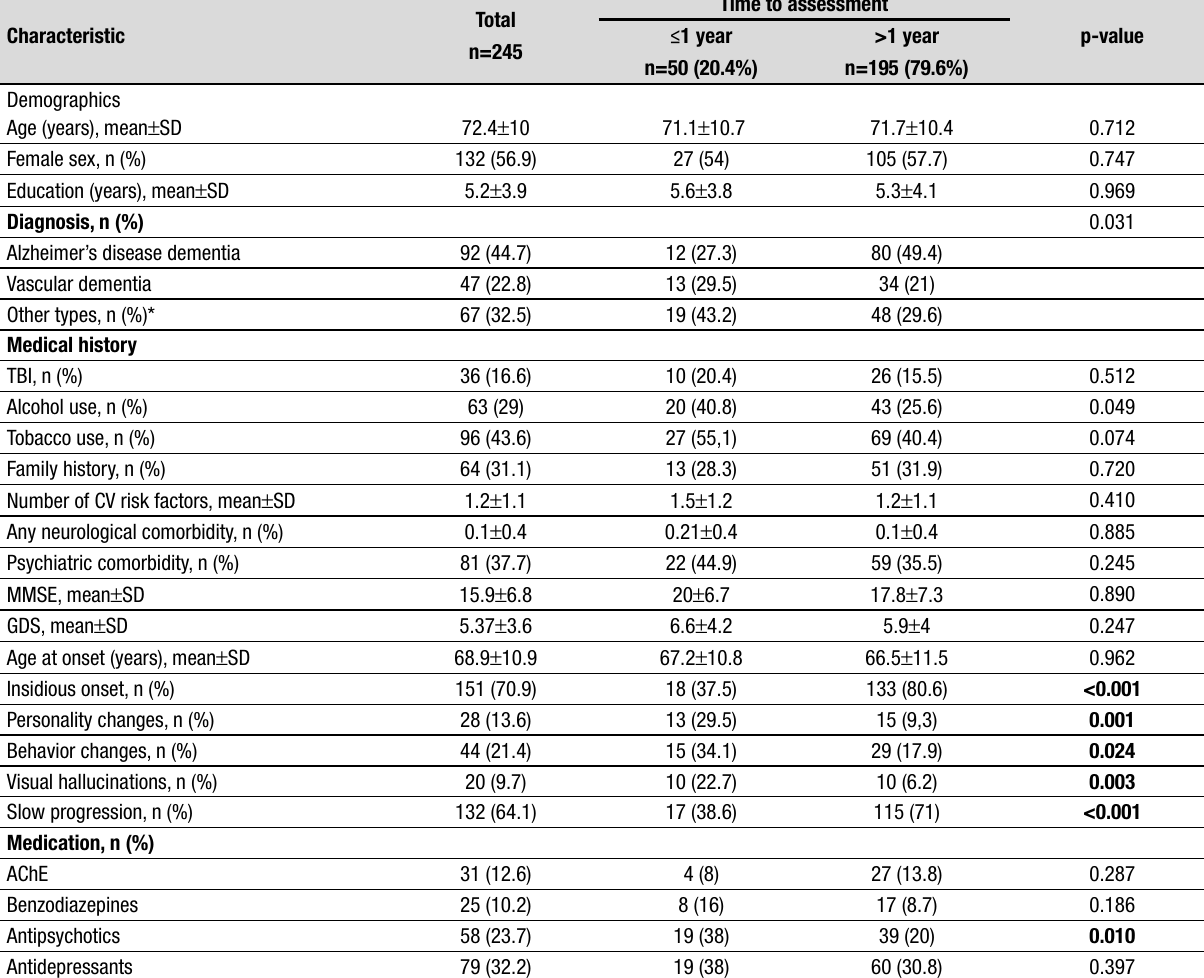
Table 1. Clinical characteristics of the groups according to time to specialist assessment